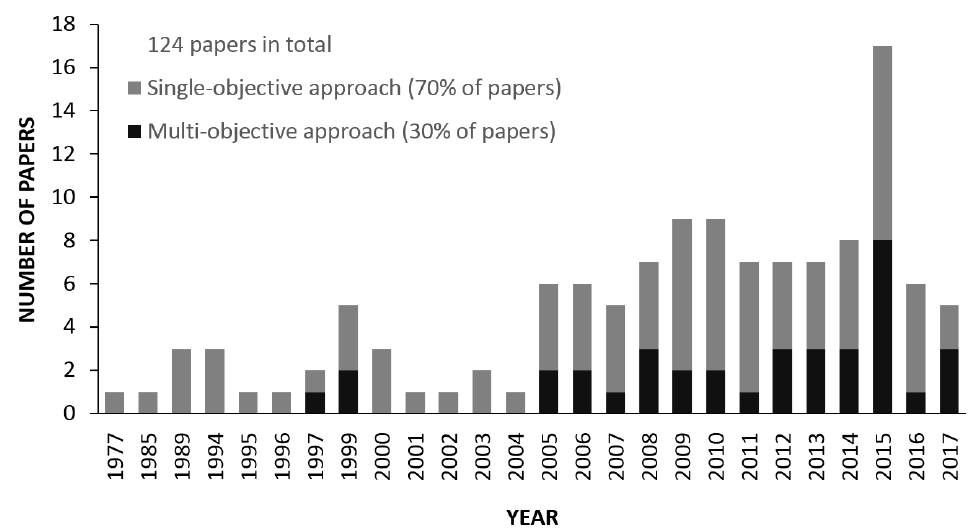
Figure 1. Papers (from the appendix table) by year and optimisation approach.